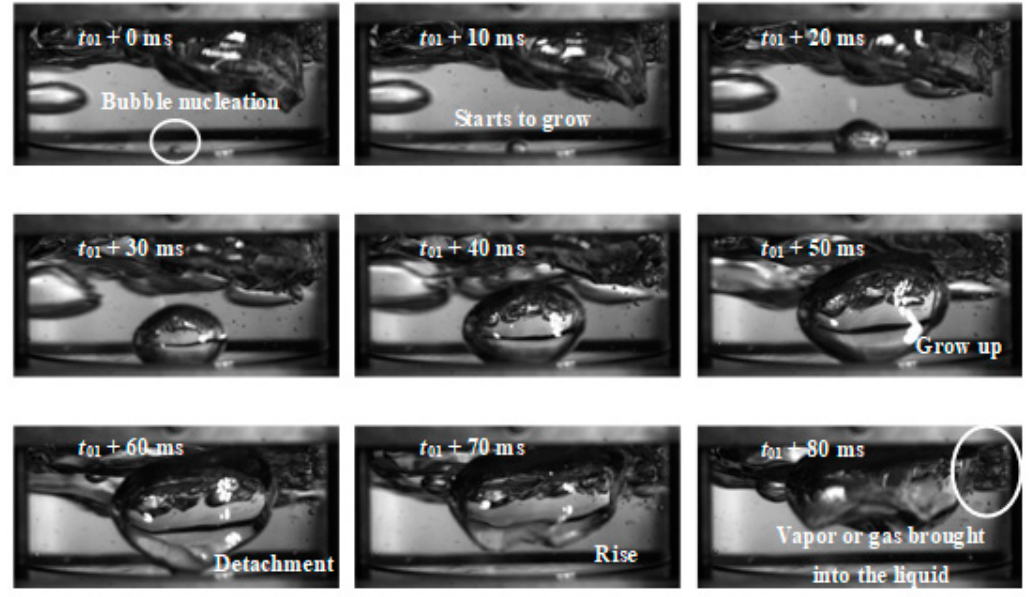
Figure 5. The evolution of gas–liquid two-phase flow pattern in cavity ( φ = 80%, q = 17.7 W/cm 2 , H = 20 mm).